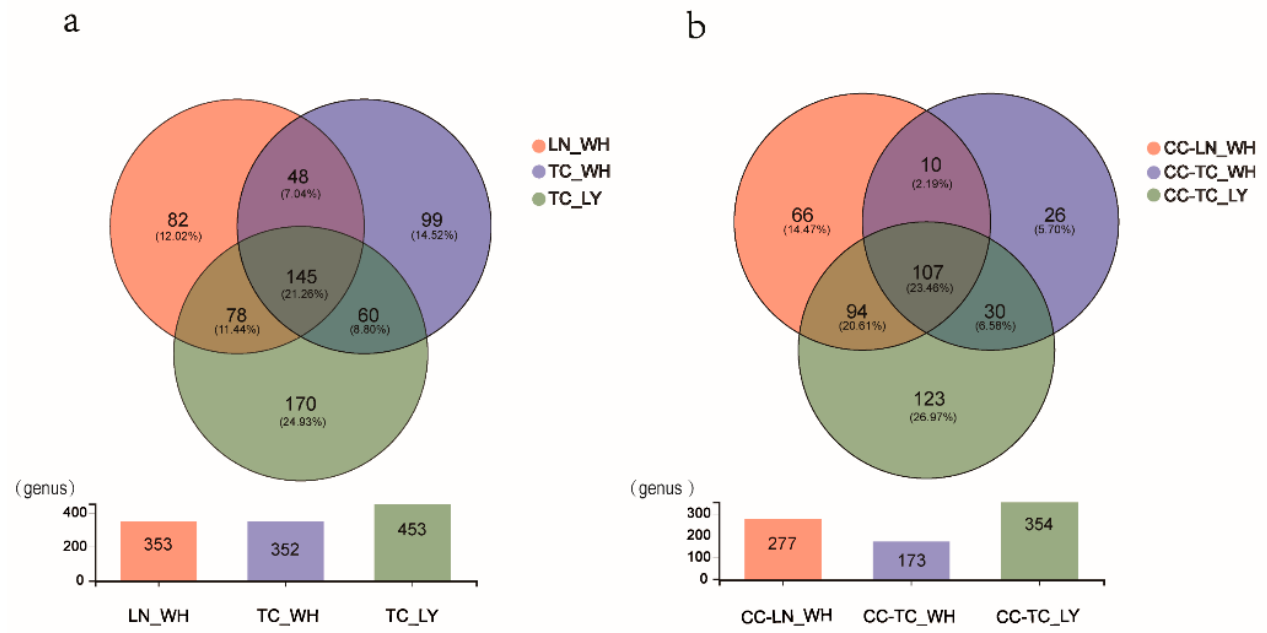
Figure 2. Venn diagram demonstrating the quantities of common and unique microorganism species at genus level between ( a ) ant groups and ( b ) spider groups. TC_LY, T. caespitum Luoyang; TC_WH, T. caespitum Wuhan; LN_WH, L. niger Wuhan; CC-, spiders fed different diets. Each measurement contains six replicates. Table 1. Richness and diversity estimation (mean ± SEM) of the bacterial community in the gut of six groups.